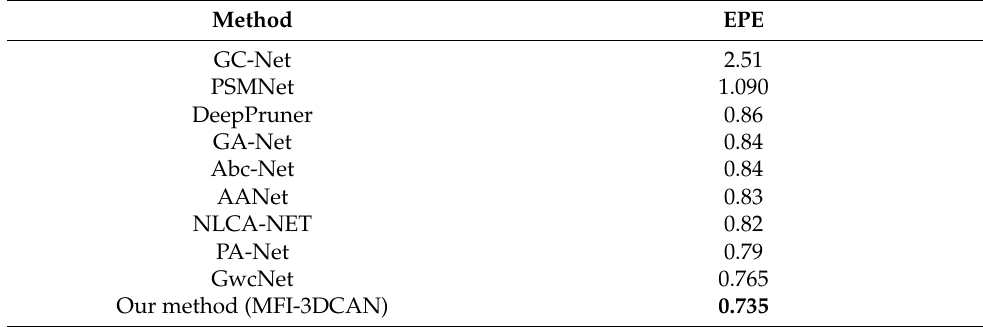
Table 3. Comparison with top-performance methods on SceneFlow with evaluation metric